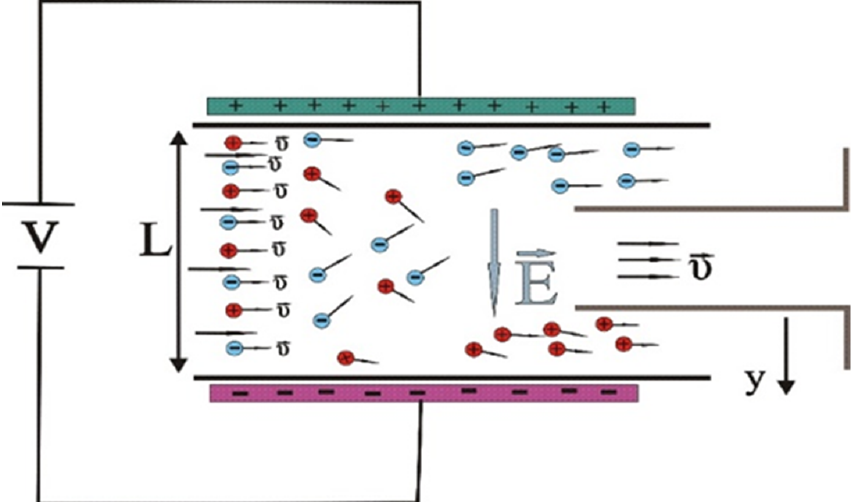
Figure 2. Configuration of ion toxin movement through the duct. (V: voltage of the electrodes; L: width of the duct, E: electric field intensity, 𝜐⃗ : velocity of ions). Due to the electric field created by the electrodes, the ions according to their charge accumulate on both sides of the duct. Throughout the analysis that follows, water is considered as a continuous medium [23–26] with electric permittivity ε = ε r ε 0 , where ε r ≈ 80 is the relative permittivity of the water and ε 0 = 8.85 × 10 − 12